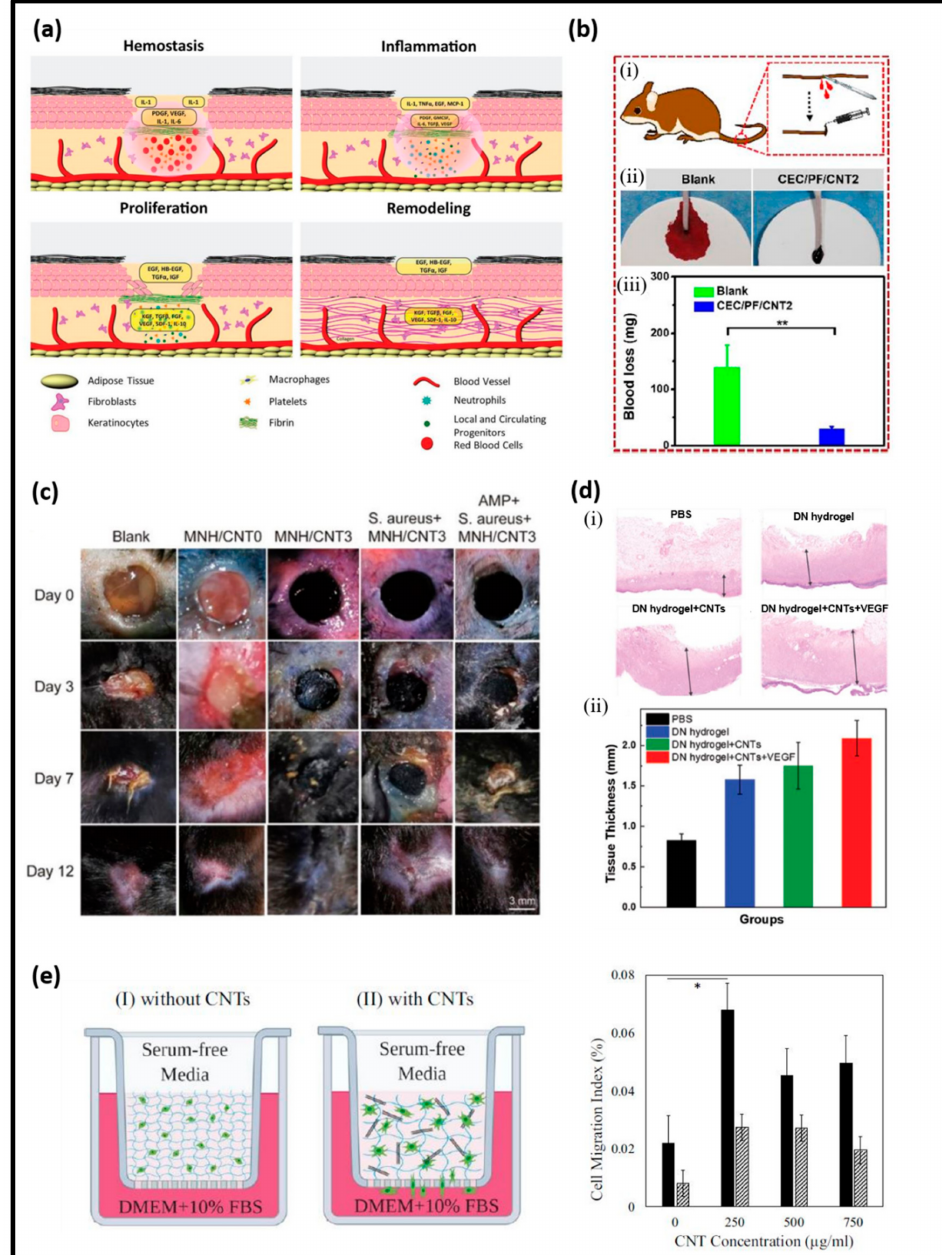
Figure 5. ( a ) Schematic representation of wound-healing phases in cutaneous wound—hemostasis, inflammation, proliferation, and remodeling [2], ( b ) (i) Scheme representation of mouse-tail amputa- tion model, (ii) bloodstain photograph of mouse tail in blank and hydrogel group, (iii) quantitative data of blood loss ( n = 5), ** p < 0.01 [137], ( c ) In vivo wound-healing model evaluation of MNH hydrogels and observation of treatment in presence of S. aureus infection for 12 days [138], ( d ) (i) H&E staining of different groups showing the progress in thickness of skin, (ii) respective statistical analysis of average connective tissue thickness in different groups [139], ( e ) Schematic of chemoattractant- induced cell migration assay using a modified Boyden Chamber experiment. The addition of CNT increased the porosity of the hydrogel and cell migration (left). The average cell migration index for the samples with varying concentration of CNT with (solid pattern) and without (diagonal pattern) chemoattractant. * p < 0.05 corresponds to a significant difference (right)